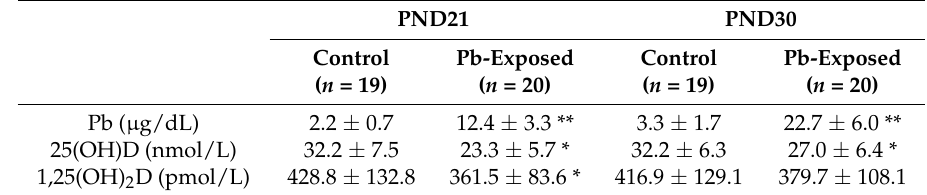
Table 3. Blood lead and serum vitamin D metabolites (Mean ± SD) in control and Pb-exposed Wistar rat pups at PND21 and